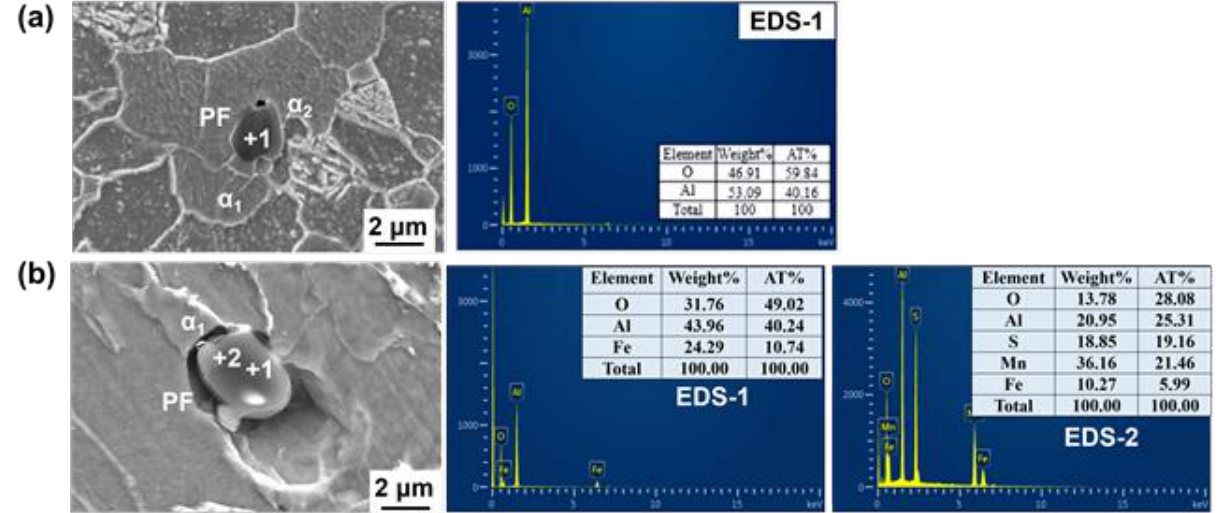
Figure 12. The relationship between inclusions and ferrite in the HAZ of No.1 steel: ( a ) Al 2 O 3 ; ( b ) Al 2 O 3 +MnS.